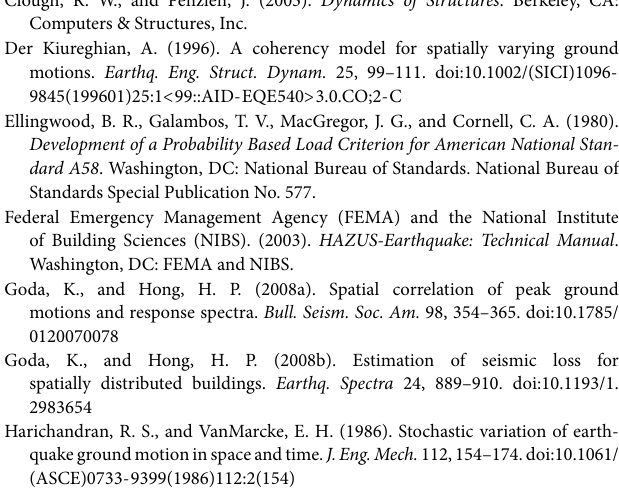
motion excitations and realistic 2DOF structural models in the seismic risk assessment of structures that are sensitive to the orientation of the